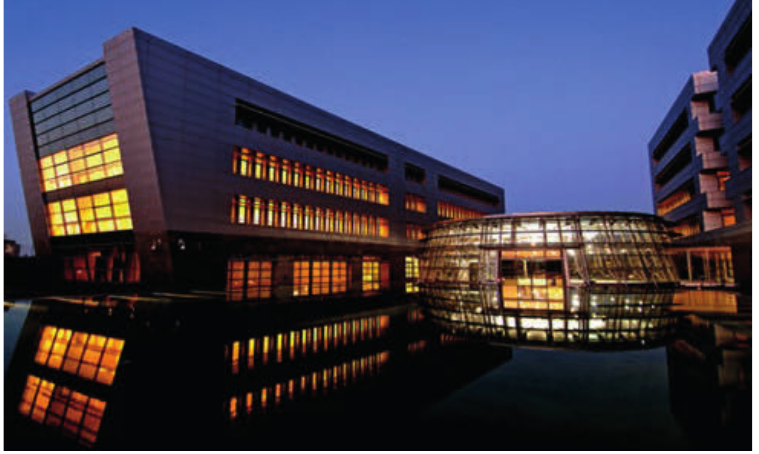
Fig. 3. Technological park of Sidi Abdallah, Algiers (NATP,